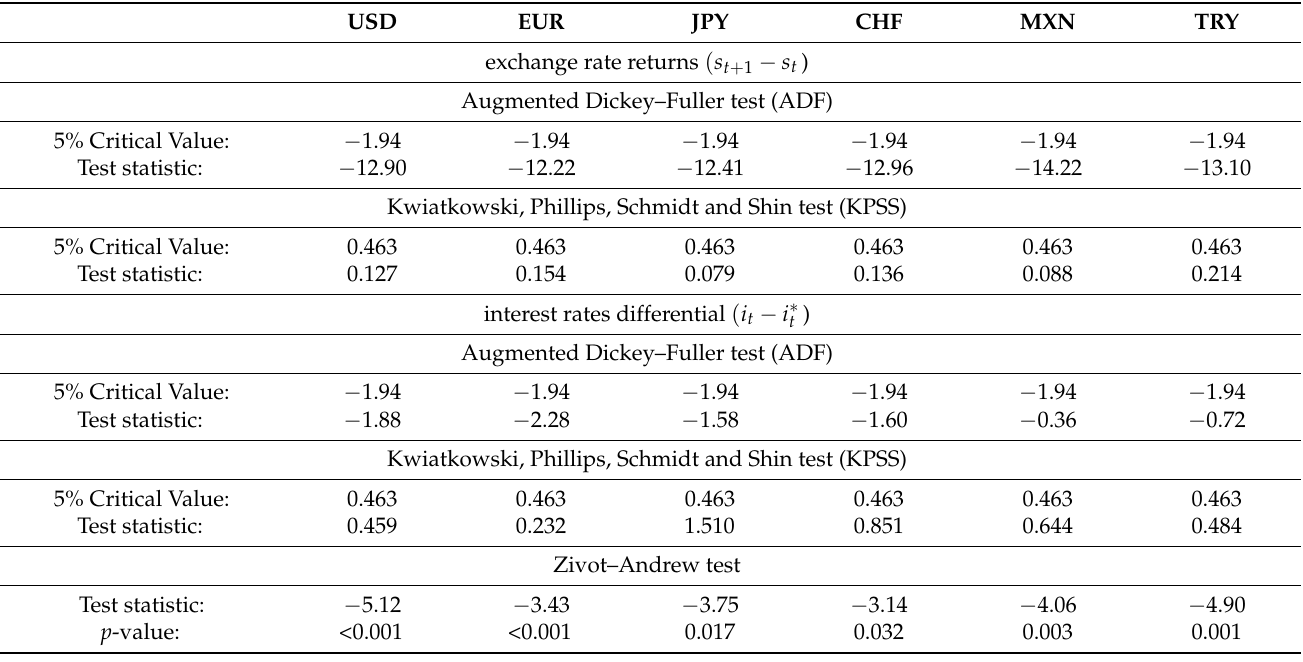
Table 1. The ADF unit root test and KPSS stationarity test results for monthly Polish zloty exchange rate returns and interest rate